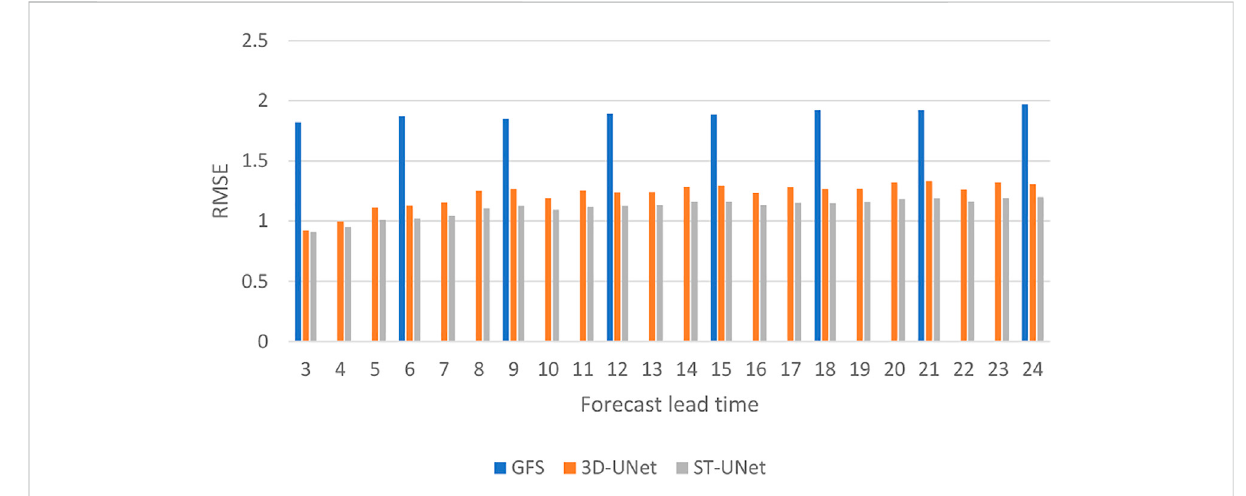
FIGURE 10 The RMSE of temporal downscaling on 2-m temperature for differents forecast times on the test